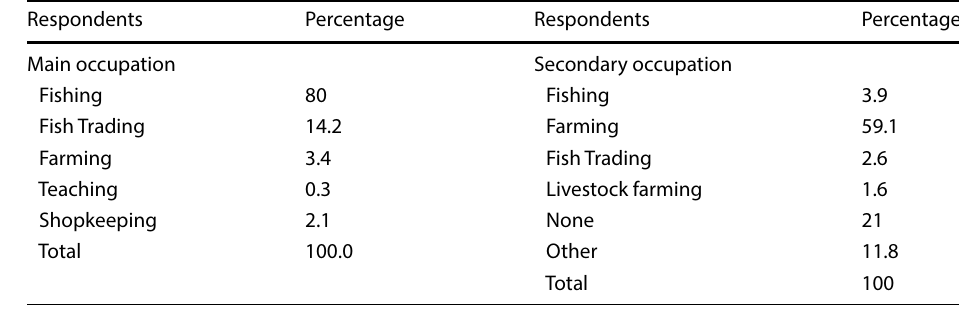
Table 3 Monthly income of 381 respondents to a questionnaire on the perception of climate changes and changes in fish biodiversity and their potential drivers, from three Ivorian climatic zones